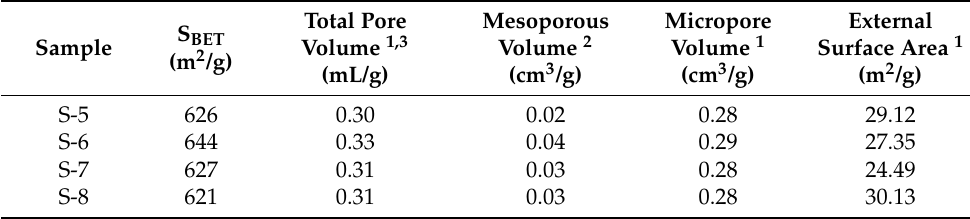
Table 2. N 2 physical adsorption data of S-5, S-6, S-7 and